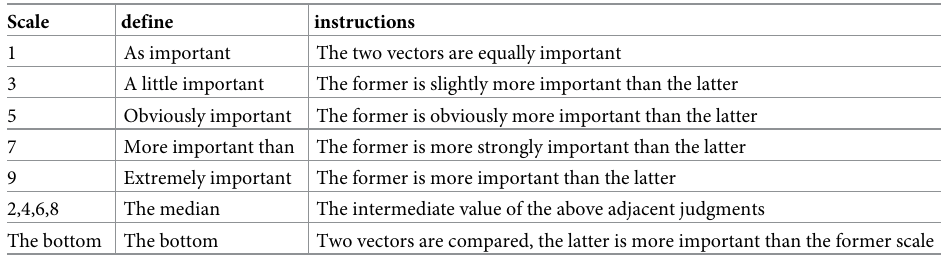
Table 4. 1–9 Scale method